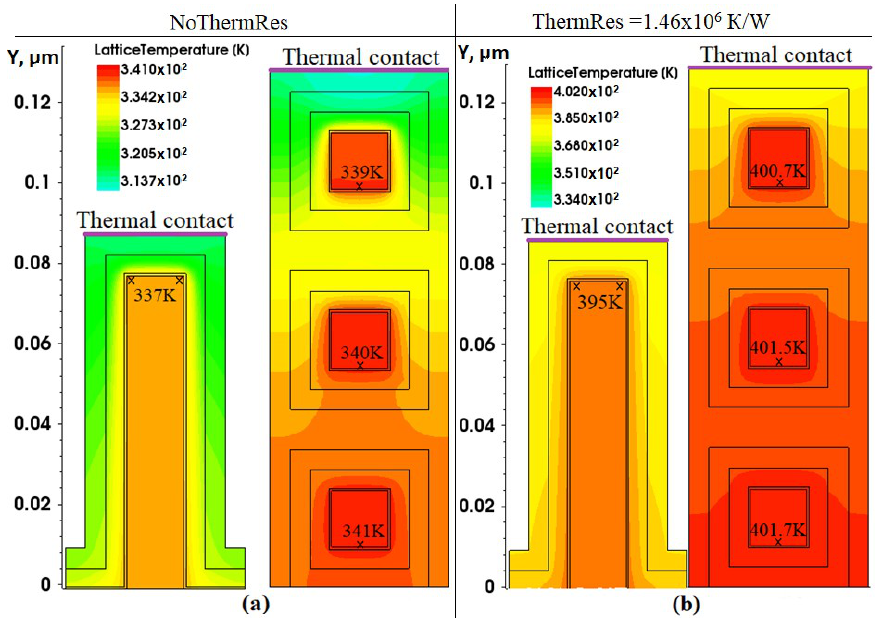
Figure 11. Temperature distributions: ( a ) in the FinFET structure; ( b ) in the NWFET structure.